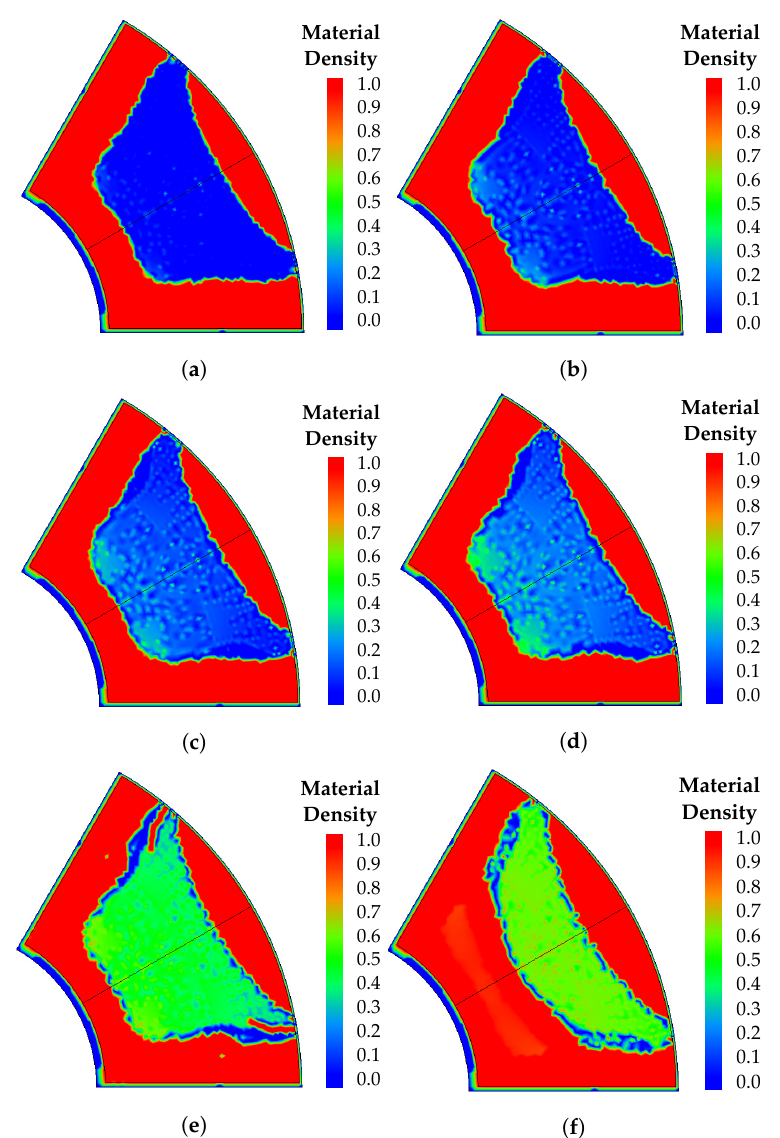
Figure 9. Material density distributions obtained with different penalization coefficient: ( a ) n = 2, ( b ) n = 3, ( c ) n = 4, ( d ) n = 5, ( e ) n = 10, ( f ) n =